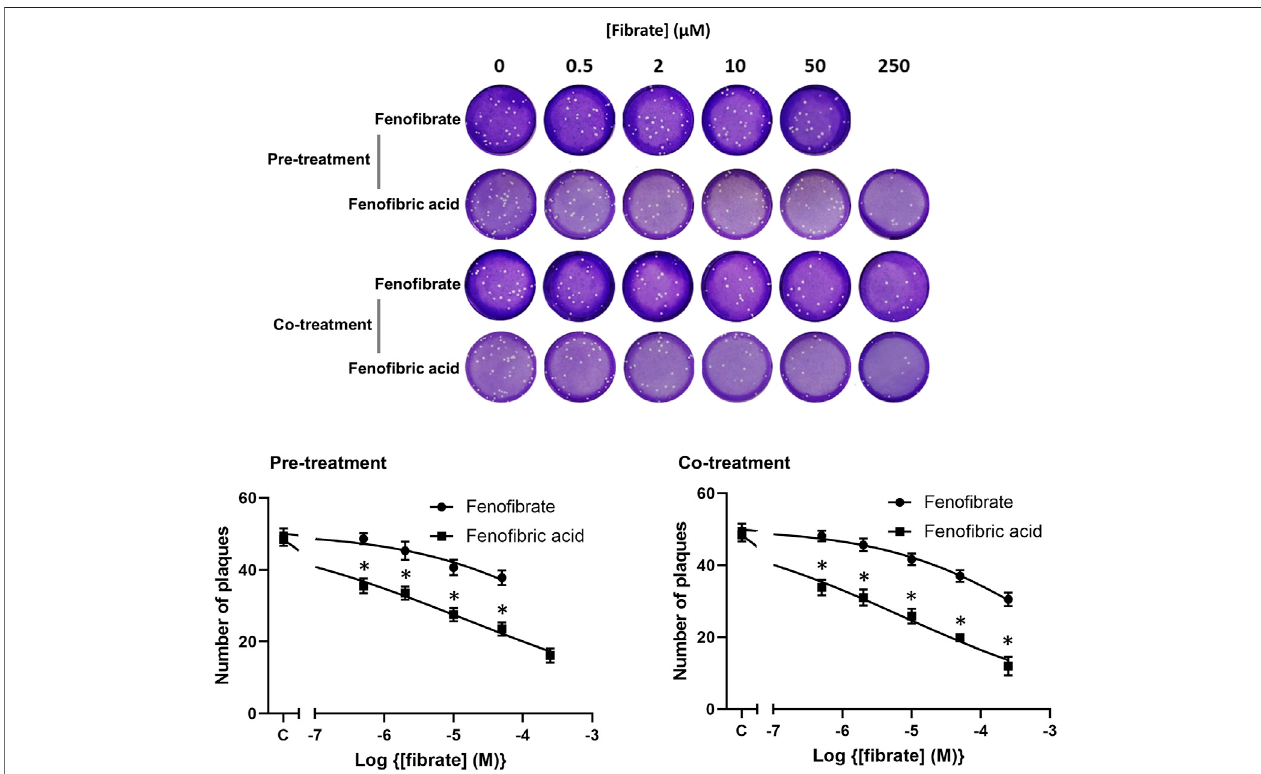
FIGURE5| FibrateinhibitionofSARS-COV-2infectionofVerocells.Antiviraleffectof fi bratesadded1 hbeforeinfectionorincotreatmentwithinfectioninVerocells with 50 PFU of SARS-CoV-2. ND, not determined due to solubility issues. The results are expressed as the number of PFU/well (mean ± SD, n (cid:2) 3). The number of plaques was signi fi cantly different (2-way ANOVA) in cells treated with feno fi bric compared to feno fi brate where shown DMSO (* p < 0.001). Compared to cells treated withdrug solvent, the number of plaques wassigni fi cantlydifferent in cells treated with feno fi bric acid ( p < 0.001, all concentrationstested) and in cells treated with feno fi brate ( p < 0.01, 10 µM feno fi brate; p < 0.001, 50 µM feno fi